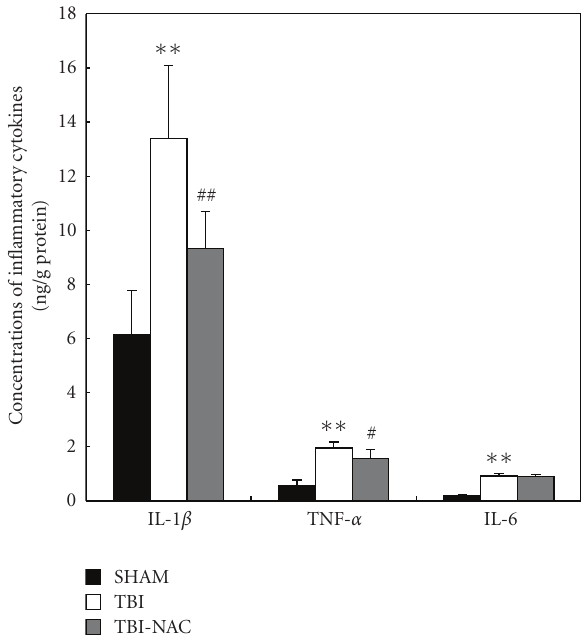
Figure 3: Changes of inflammatory mediators in the injured brains as determined by ELISA in SHAM group ( n = 5), TBI group ( n = 6), and TBI-NAC group ( n = 6). TBI could induce the significantly increased concentrations of IL-1 β , TNF- α , and IL-6 in the rat brain surrounding the injury site. In TBI-NAC group, the cortical concentrations of IL-1 β and TNF- α but not IL-6 were markedly downregulated as compared with that of TBI group. ∗∗ P < . 01 versus SHAM group; # P < . 05 and ## P < . 01 versus TBI